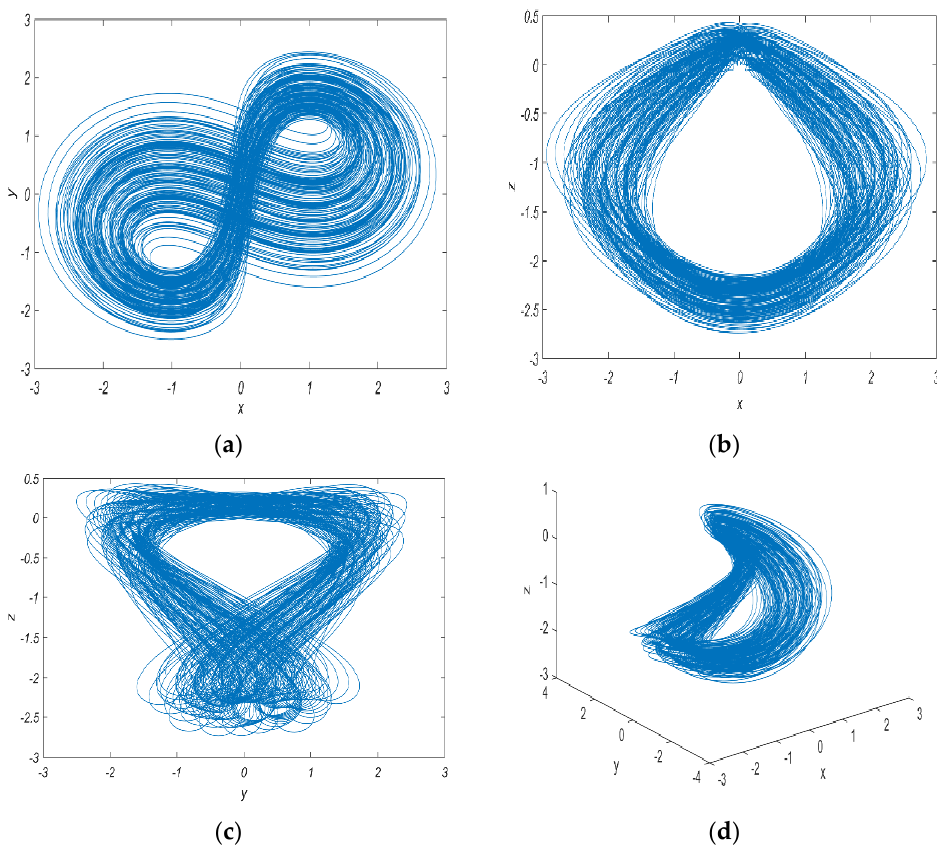
Figure 2. Phase portraits of the self-excited chaotic attractors obtained from the system (5): ( a ) x-y projection; ( b ) x-z projection; ( c ) y-z projection; ( d ) x-y-z 3D